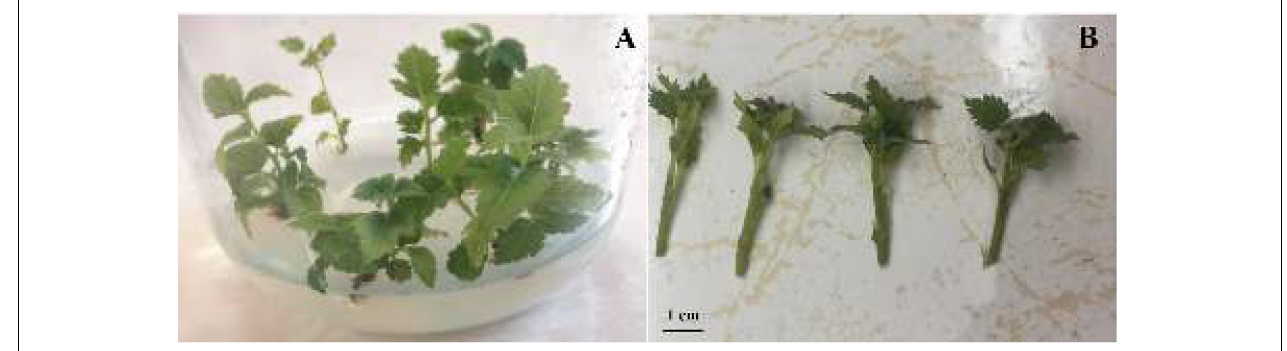
FIGURE 1 | In vitro pre-culture of diploid and tetraploid explants on PGR-free MS medium as the explant source for water stress experiment (A) , and the isolated shoot tip explants for implementation of water stress treatments (B) .